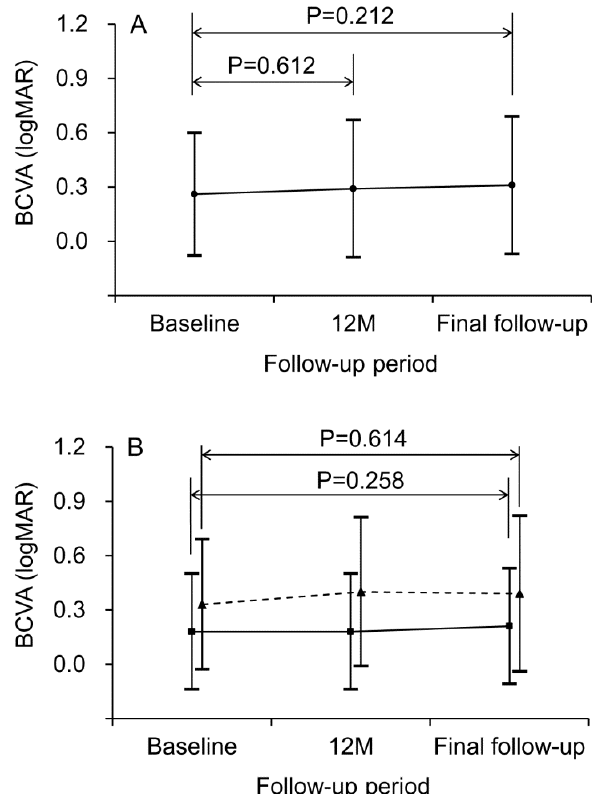
Figure 2. Changes in BCVA during the follow-up period. ( A ) All 19 patients, ( B ) When divided into 2 groups, according to the lesion size. The solid line indicates the small lesion size group and the dashed line indicates the large lesion size group. Statistical analysis was performed using the Wilcoxon signed-rank test with Bonferroni’s correction. BCVA = best-corrected visual acuity, logMAR = logarithm of the minimum angle of resolution, M = months.